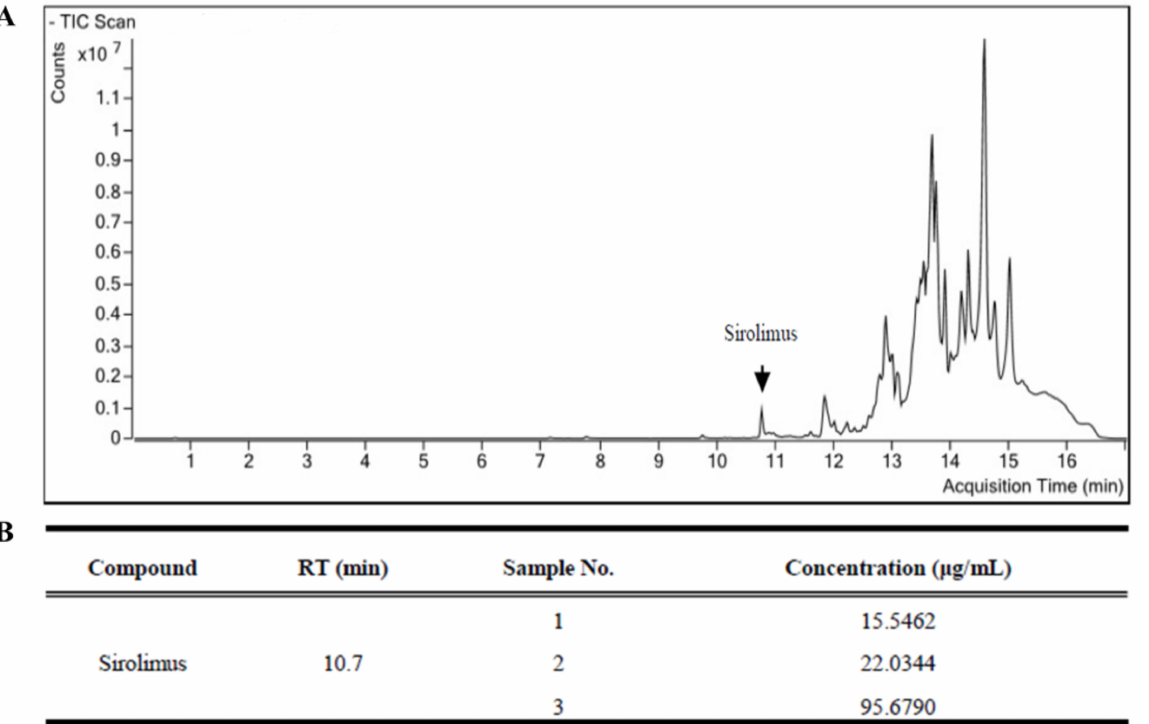
Figure 2. The liquid chromatography–mass spectrometry (LC-MS) analysis identifying the sirolimus release from silk microneedle (MN) wrap. ( A ) Appropriate detection of sirolimus at 10.7 min and ( B ) concentration of sirolimus in three vein grafts wrapped with sirolimus-embedded silk MN